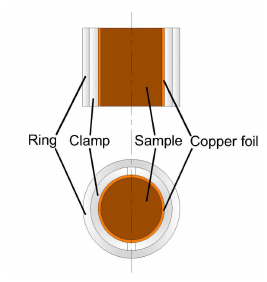
Figure 1. Gripped oil shale